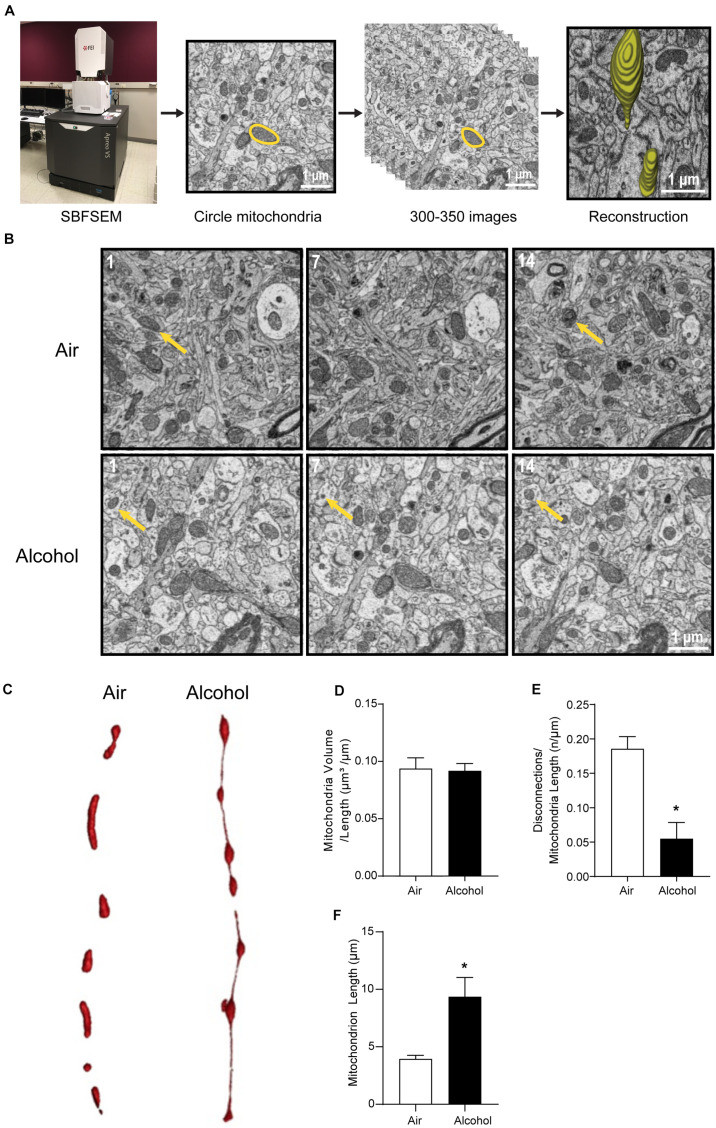
Three-dimensional morphological changes of the ACC mitochondria. (A) Representative patterning of mitochondria reconstruction in three-dimensional SBFSEM study.*: Mayo Clinic Microscopy and Cell Analysis Core’s FEI Apreo VS SEM. (B) A series of 50-nm sections showing representative mitochondria in ACC from the alcohol and air groups. The 1st, 7th, and 14th sections were selected from the same sample in two groups. Yellow arrows indicate representative mitochondria in those sections. (C) Representative three-dimensional mitochondrial reconstruction in air and alcohol groups. (D) Quantification of mitochondria volume. (E) Quantification of disconnections (mitochondrial ends) per mitochondrial length. (F) Quantification of mitochondrial length. N = 8 mitochondria per mouse. Asterisks (*) represent significance exists between two groups (P < 0.05) after unpaired Student’s t-test.